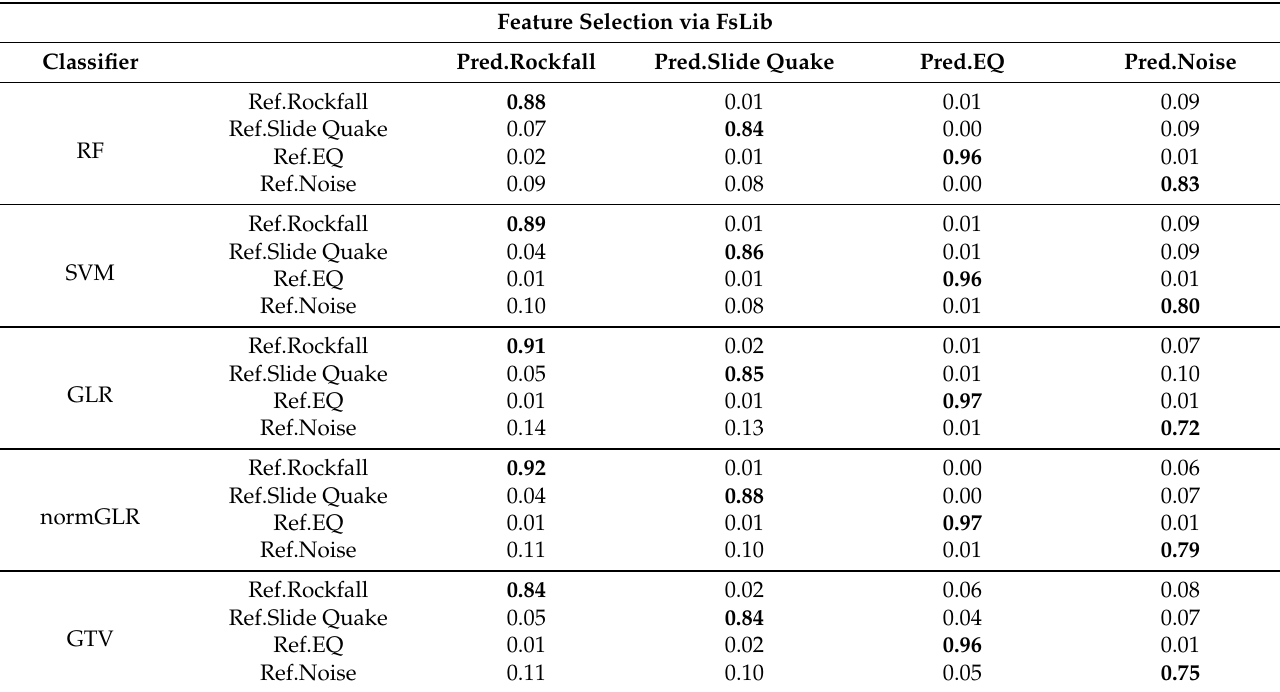
Table 5. Mean Confusion Matrix (sensitivity score) averaged over 50 runs (FsLib and graph-based feature weight optimisation) a